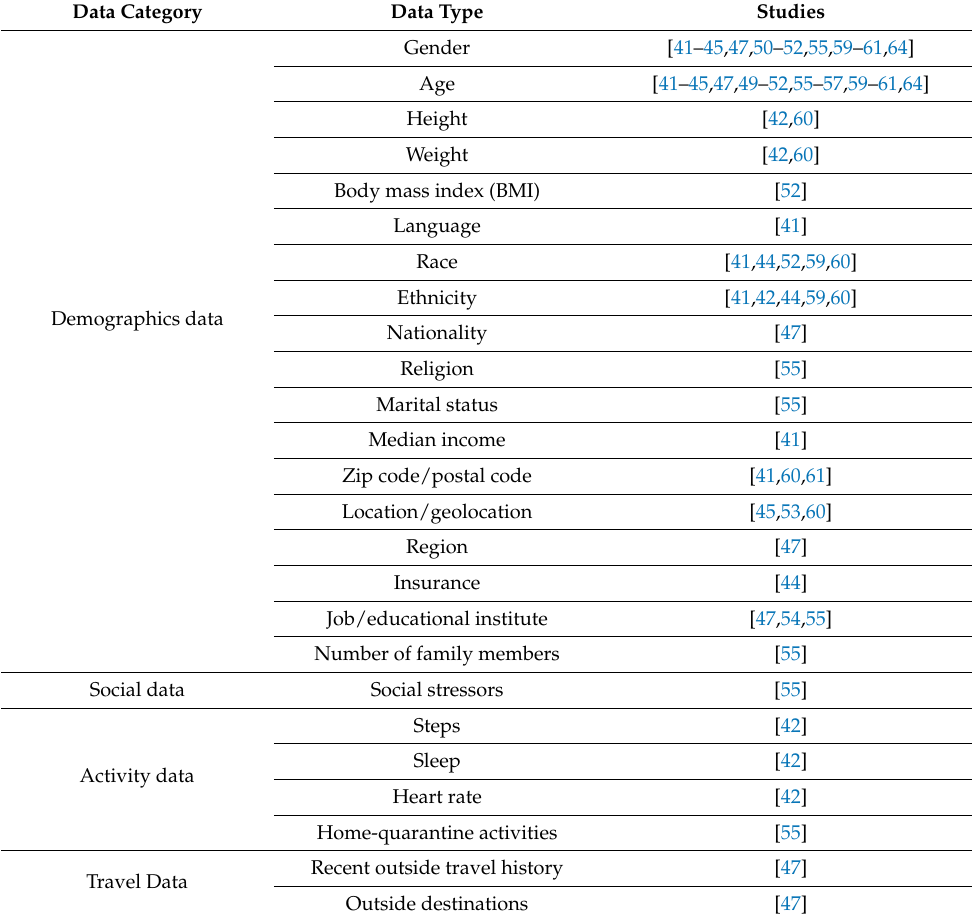
Figure 3. COVID ‐ 19 data distribution in the reviewed studies. Figure 3. COVID-19 data distribution in the reviewed studies. Table 5. Demographics, social, activity, and travel data found in the reviewed